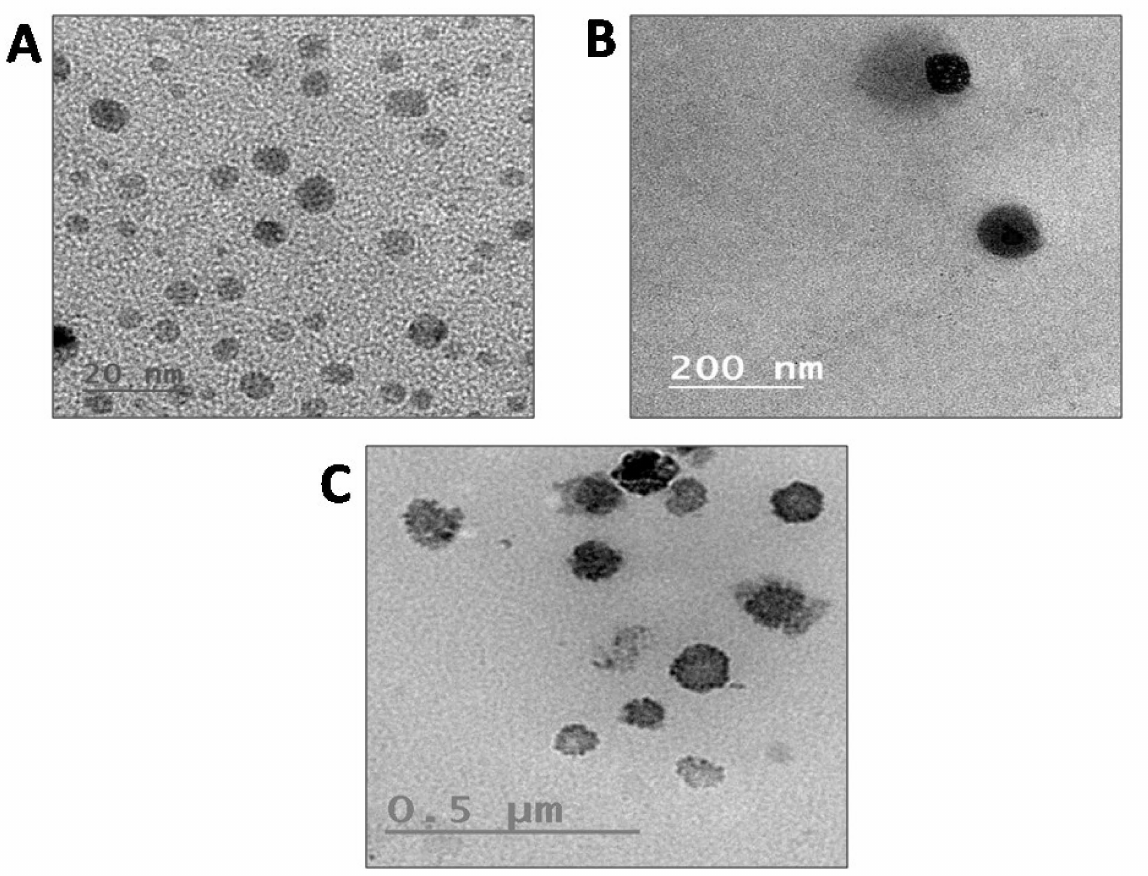
Figure 2. TEM images of <50 nm sized phenytoin sodium loaded NLC ( A ), 50–100 nm sized phenytoin sodium loaded NLC ( B ) and >100 nm sized phenytoin sodium loaded NLC ( C